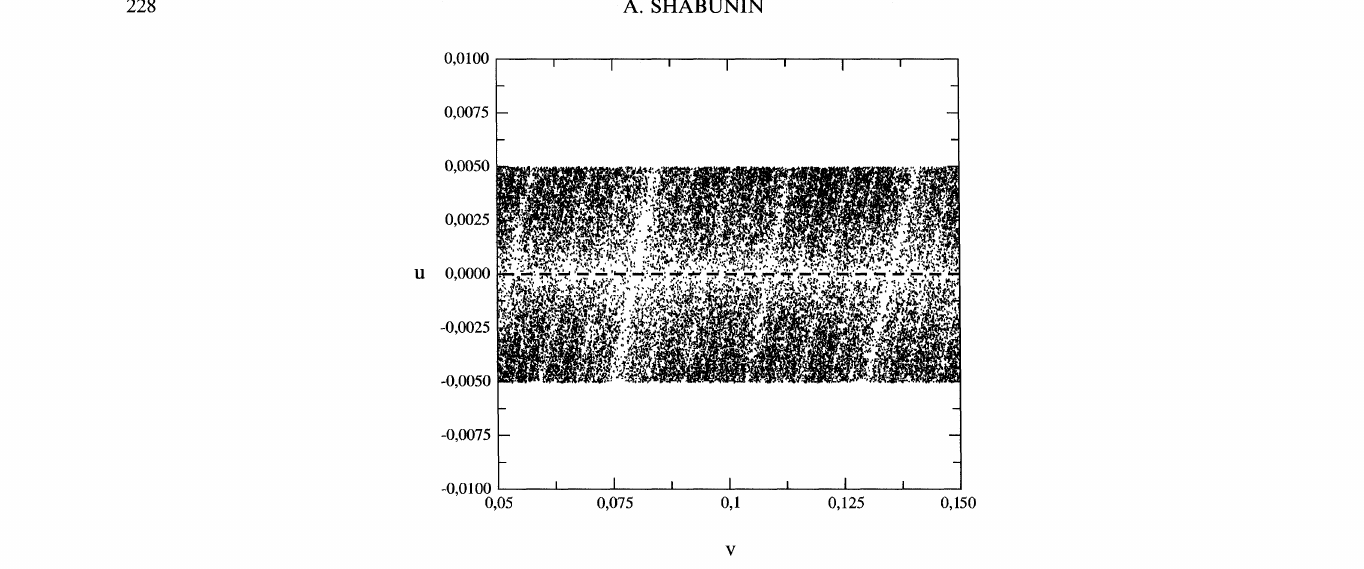
FIGURE 10 A part of the basins of the chaotic attractor inside the antisymmetric subspace (white color) at 1.485. The black color denotes regions relating to the basins of the attractor in the